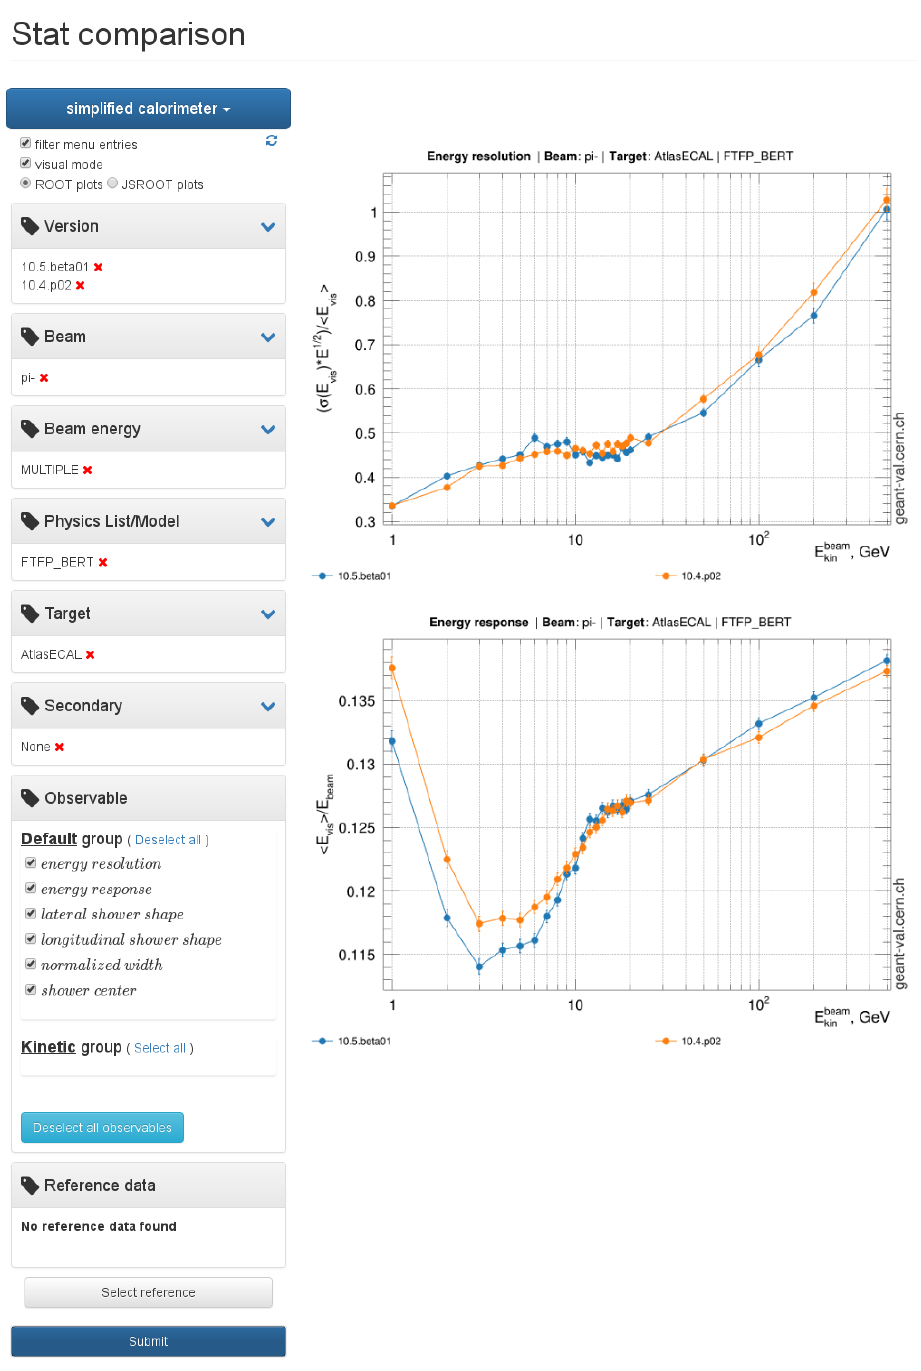
Figure 2. Plots of "simplified calorimeter" test results for Geant4 releases 10.5.beta01 and 10.4.p02 with 10.5.beta01 selected as